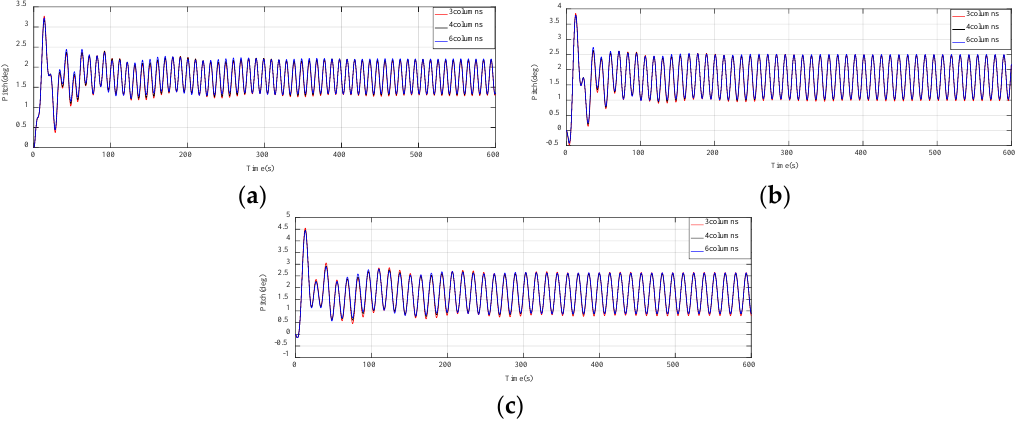
Figure 11. Pitch response for all three platforms under wave loadings ( a ) LC1, ( b ) LC2, and ( c ) LC3.